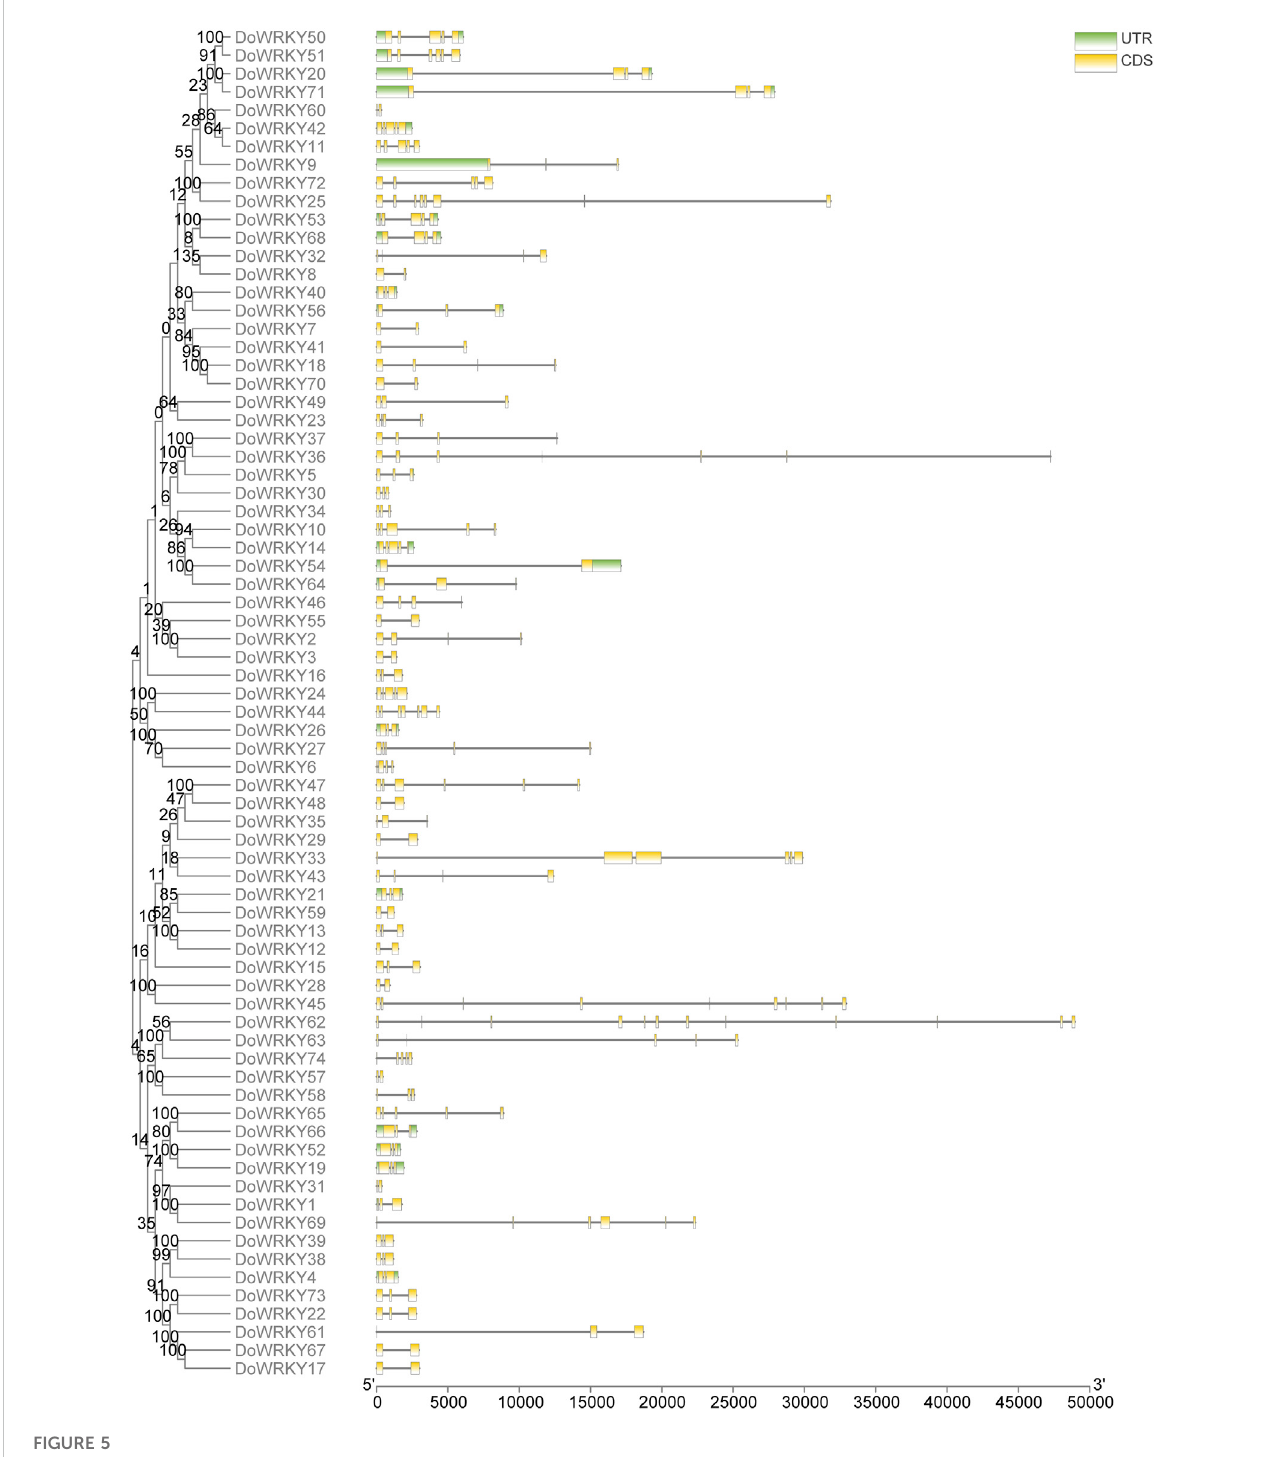
The gene structure analysis of DoWRKY